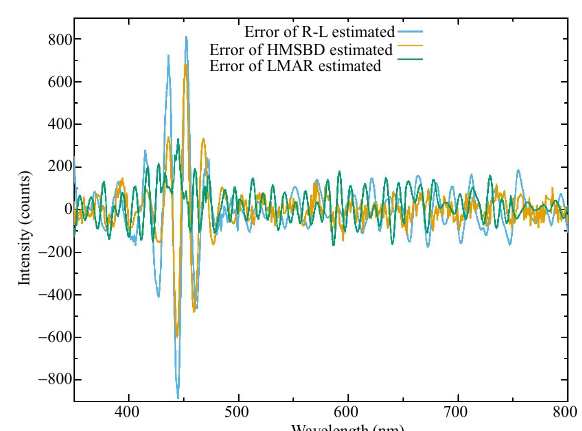
Fig. 11 Correction errors of all three methods for processing white LED 1# spectrum.